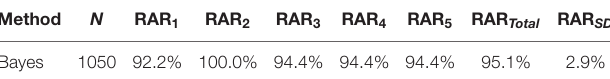
TABLE 2 | Recognition accuracy rates (%) of direct Bayes model in modeling. Method